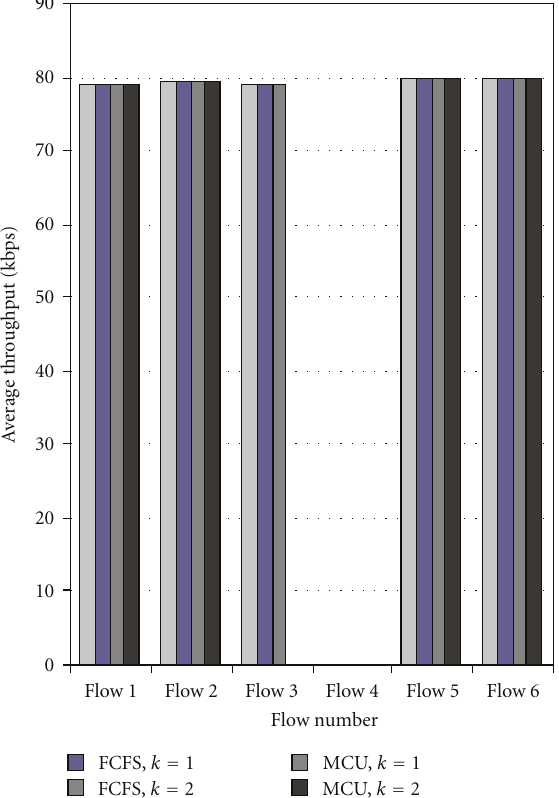
Figure 16: Average throughput of each flow for adaptive δ υ FCFS and maximum utilization based